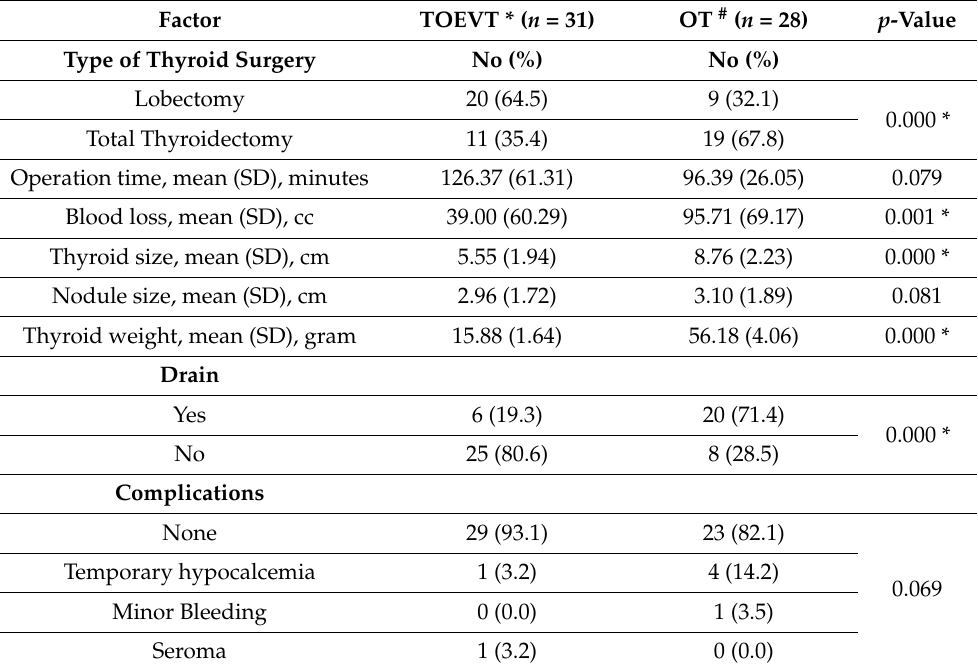
Table 2. A comparison of the surgical outcomes between transoral endoscopic vestibular and open thyroidectomy ( n = 59).